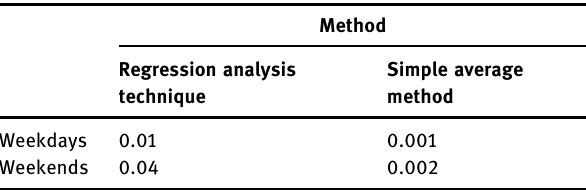
Table 7: MAPE values for regression analysis technique and simple average method